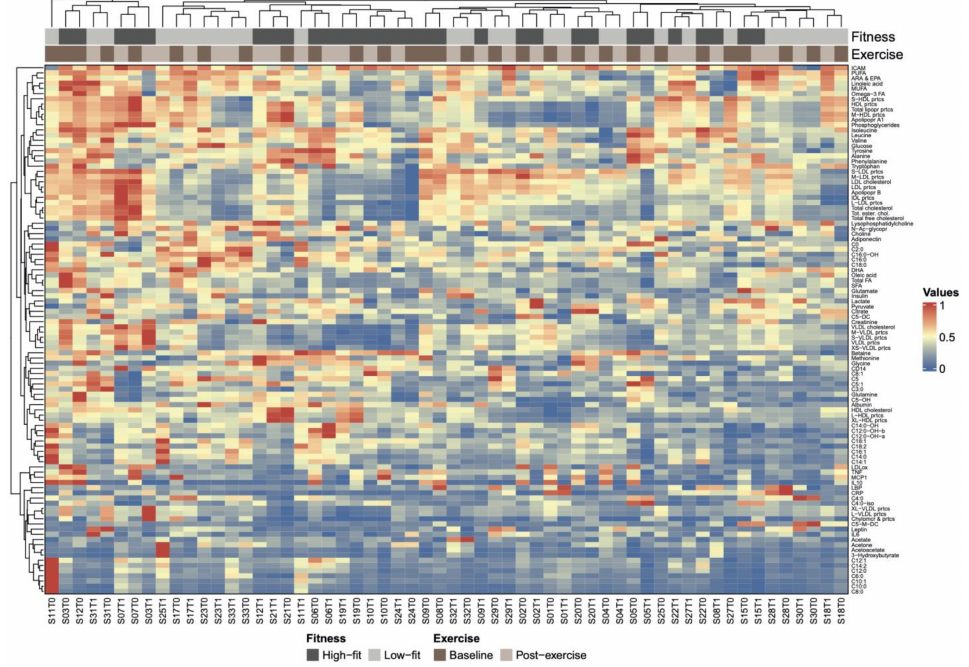
Figure 4. Heatmap of hierarchically clustered biomarkers and metabolic parameters and the association with fitness level and recent exercise. Heatmap based on hierarchical clustering of